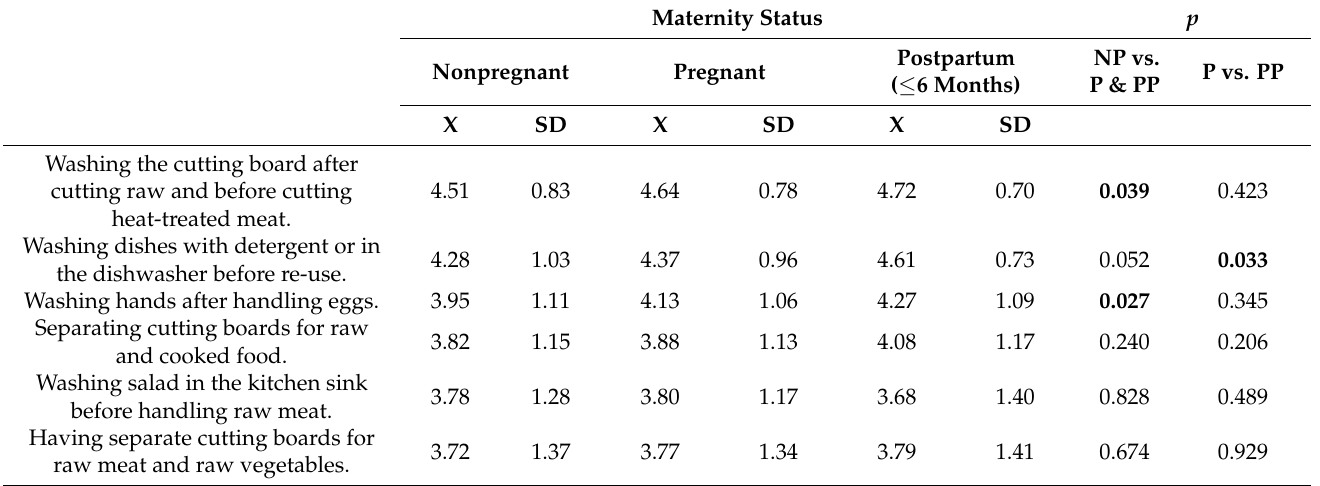
Table 6. Frequency (arithmetic mean) of self-reported practices related to cross-contamination prevention by maternity status, listed from highest to lowest overall mean.